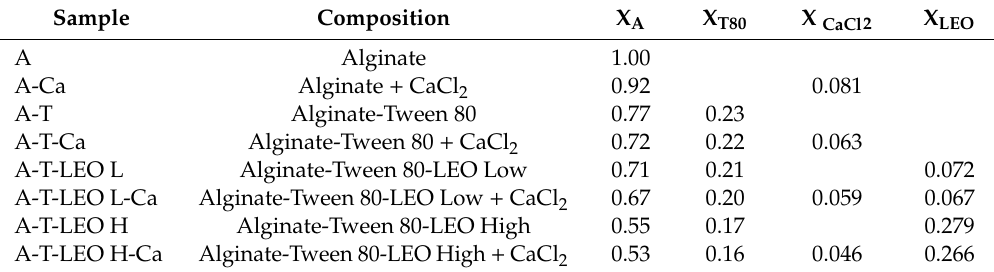
Figure 1. Representation of the application of calcium chloride solution on films through spaying. Table 1. Sample codes, composition and nominal mass fraction (X) of different components in the dried films.